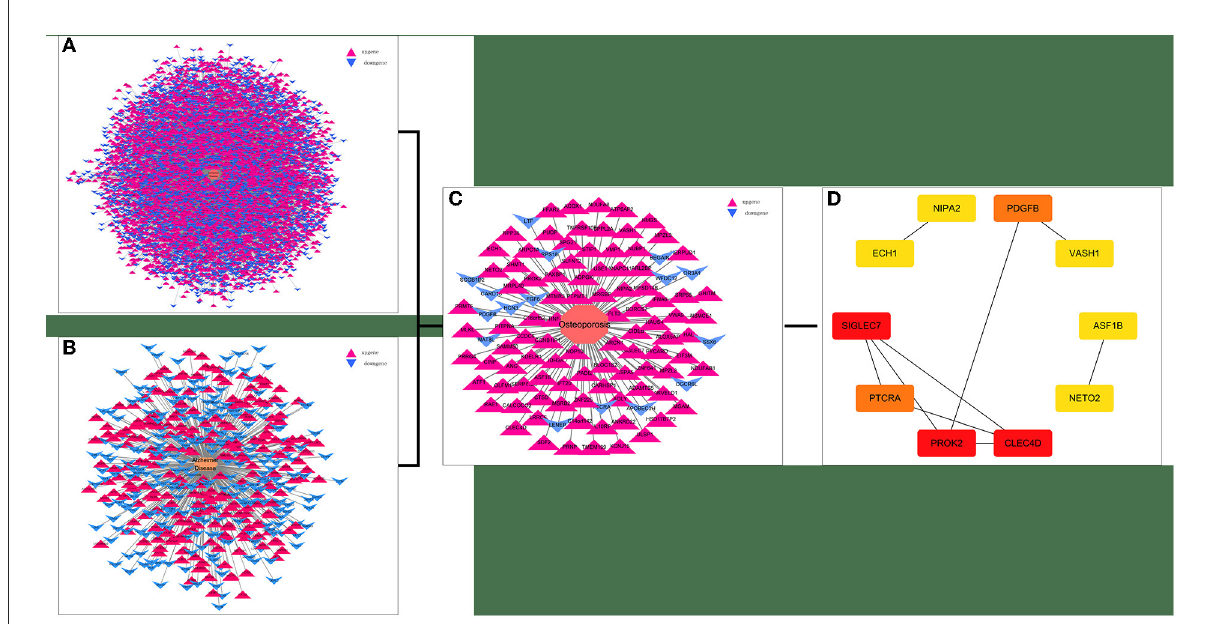
FIGURE3 Screening for AD-OP-related DEGs in peripheral blood and construction of PPI networks. (A,B) GSE168813 differentially expressed gene interaction network; (C) GSE62402 differentially expressed gene interaction network; (D) top 10 potential core target genes based on degree